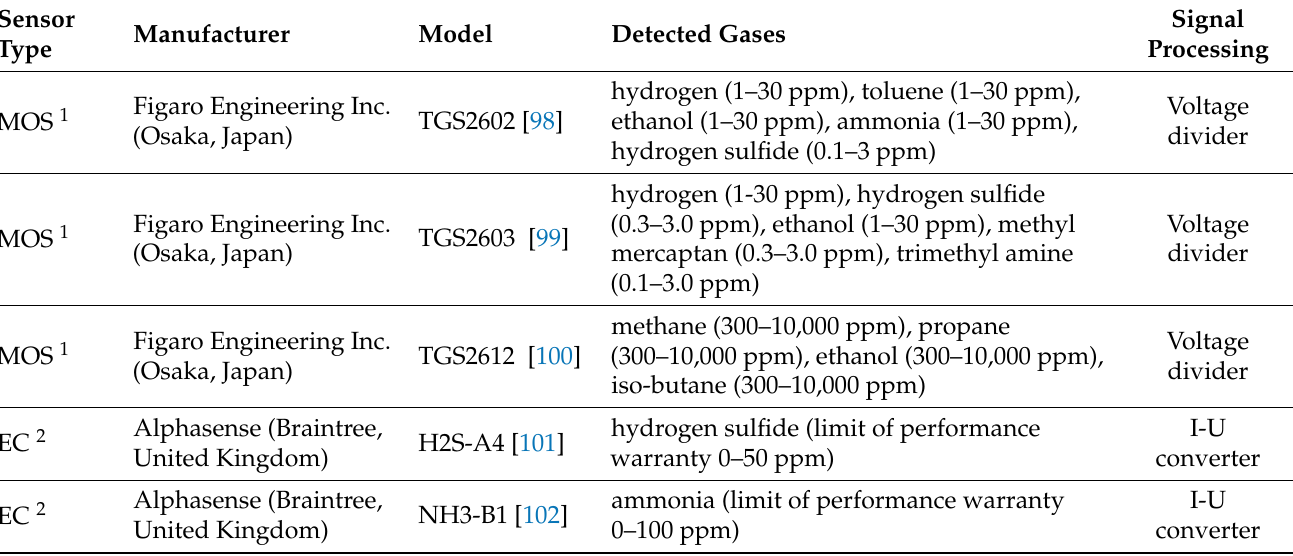
Table 3. Basic characteristics of selected chemical gas